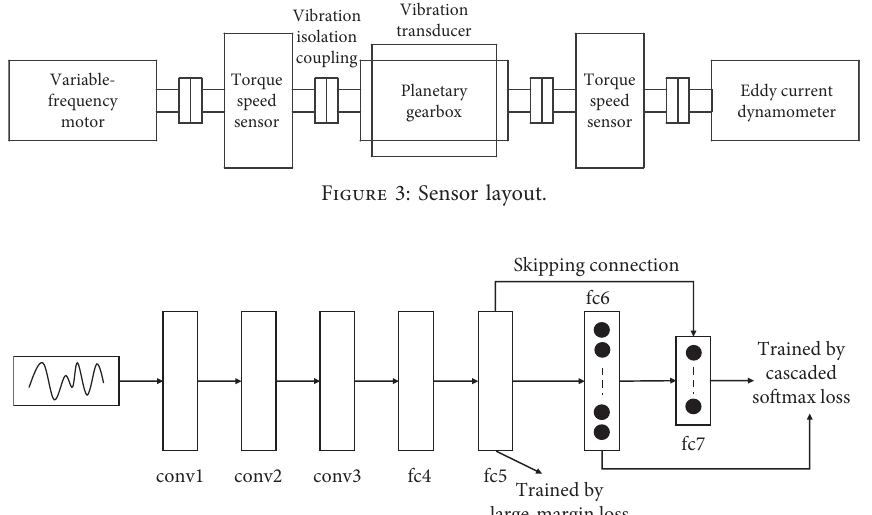
Figure 4: Structure of the proposed fine-grained fault signal classification